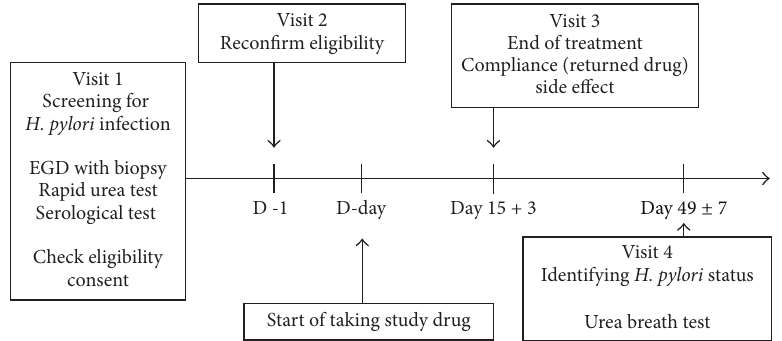
Figure 1: Flow chart of study methodology. EGD: